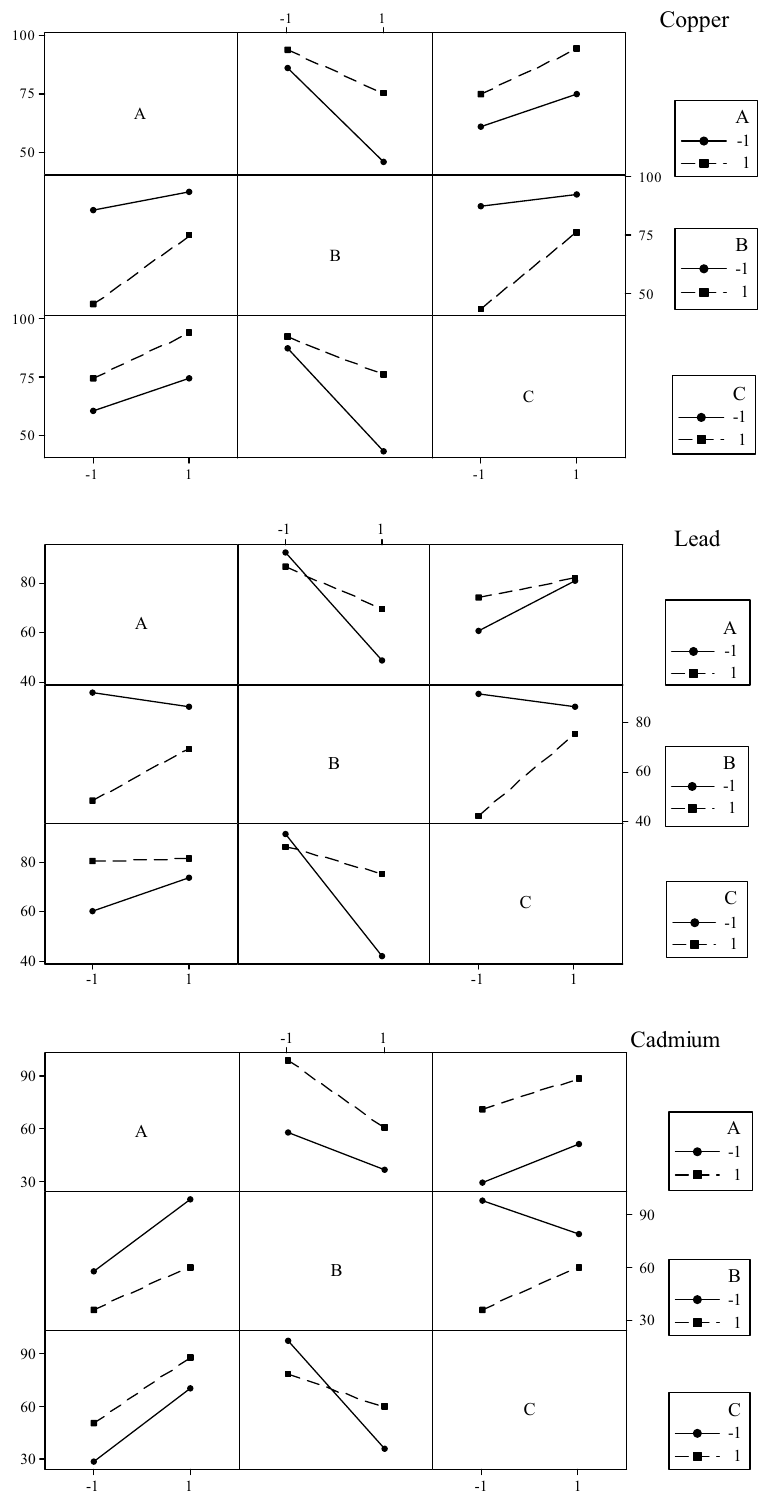
Figure 5. Interaction effects plot for removal efficiency of Cu 2+ , Pb 2+ and Cd 2+ . A pH; B C 0 ; C D